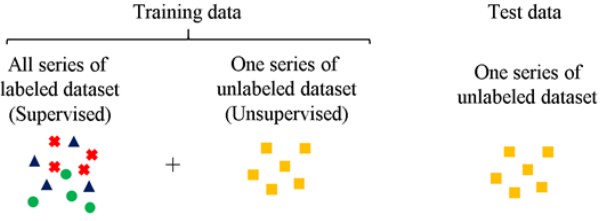
Fig. 3. Treatment of training data and test data.